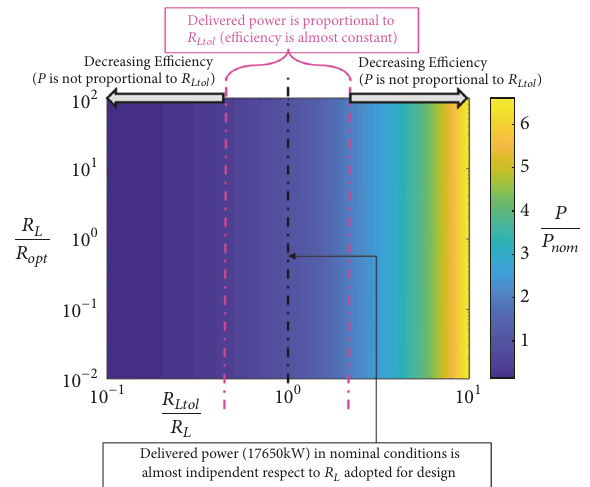
Figure 16: LCC compensation, behavior of power transfer P with respect to its nominal design value 𝑃 𝑛𝑜𝑚